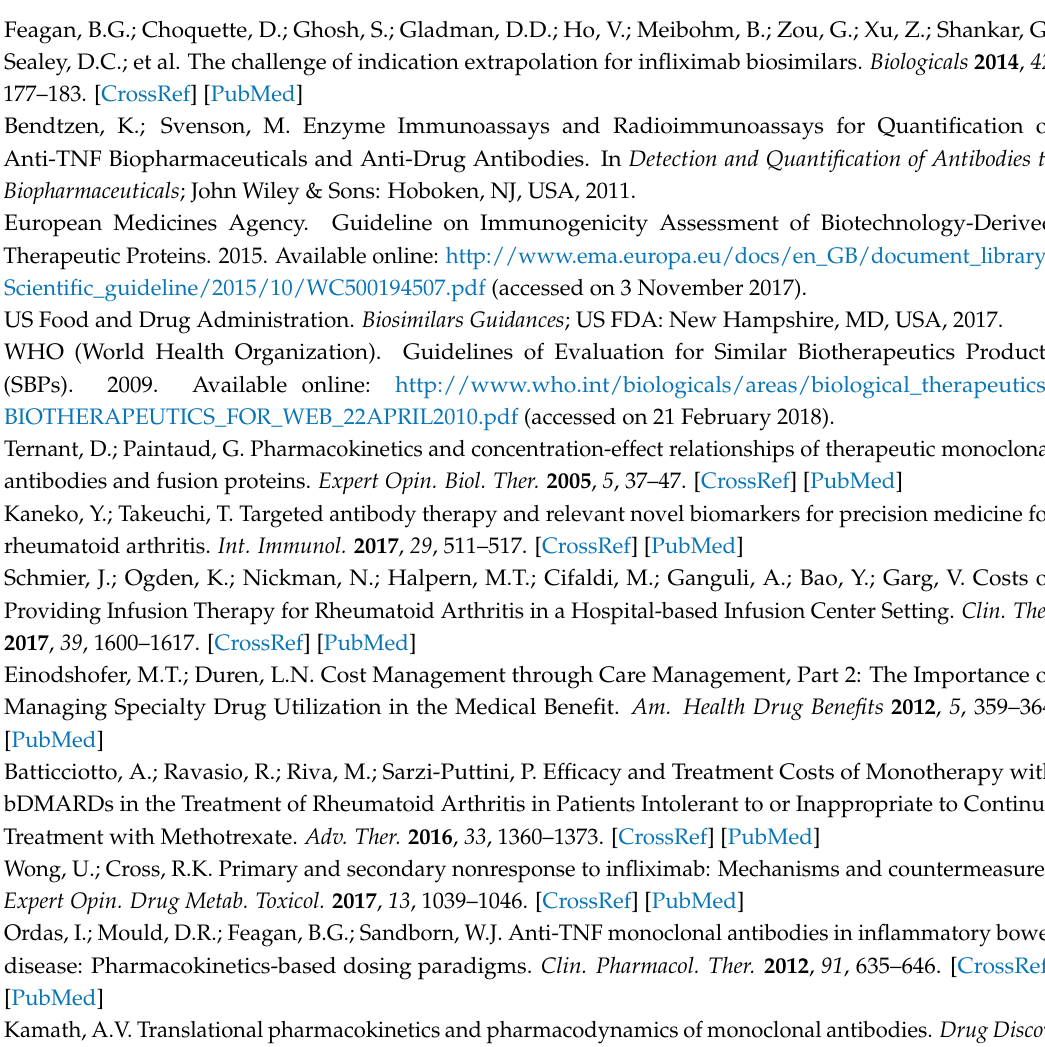
Figure A1. Calibration curve obtained using a commercial ELISA kit.